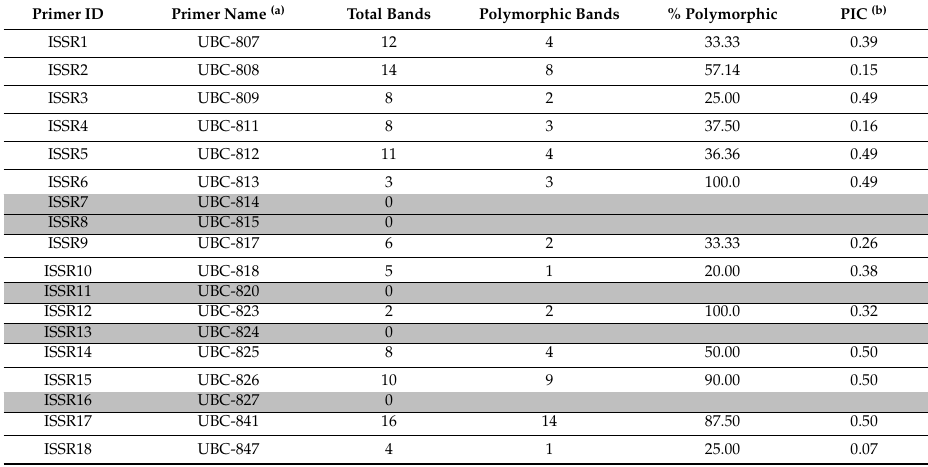
Table 2. Polymorphism in 59 rice blast strains revealed by inter-simple sequence repeat (ISSR) primers. Primer